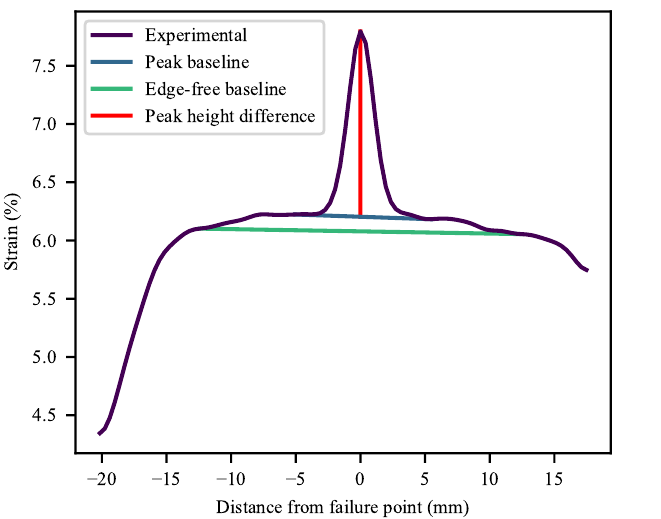
Figure 16. Example fitting, 1.8-CB/30-CC/0.25-SP WL. Fit on the yield time-step. The fitted parame- ters are used in Equations (22) and (23).